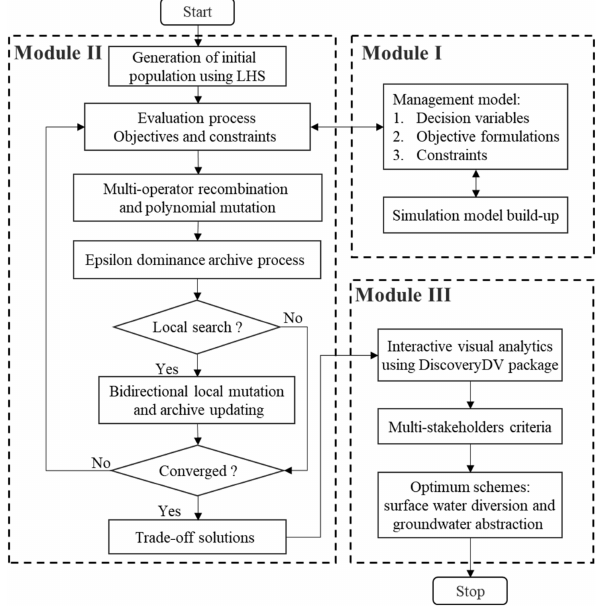
Figure 1. Framework of multi-objective optimization for integrated SW–GW